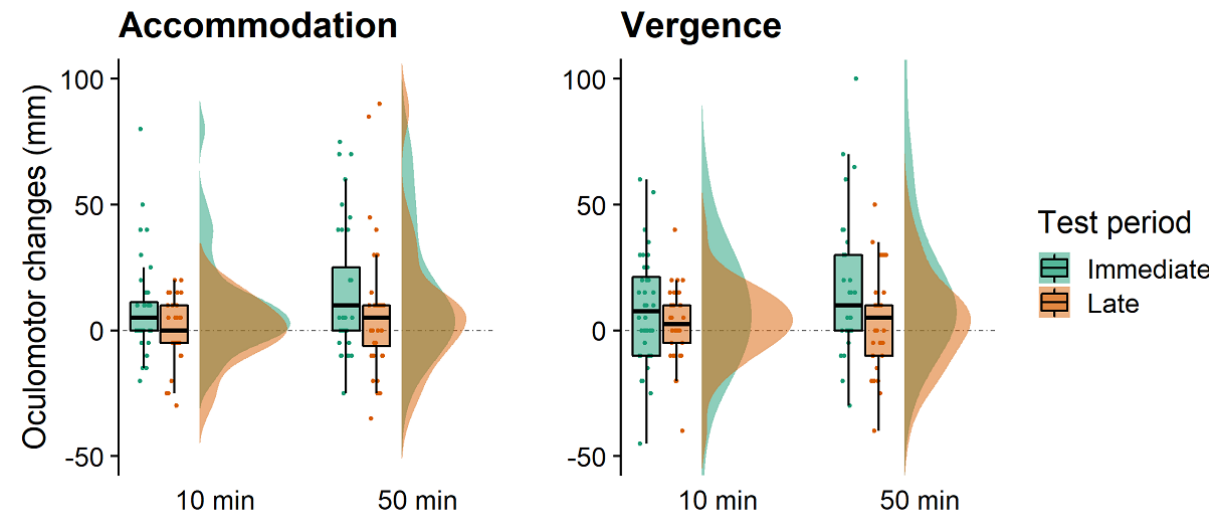
Figure 2. Raincloud plots for accommodation (left) and vergence (right) measures showing the different test periods and virtual reality exposure times. Positive and negative scores, respectively, indicate an increase (further) or decrease (nearer) change in accommodation or vergence from baseline